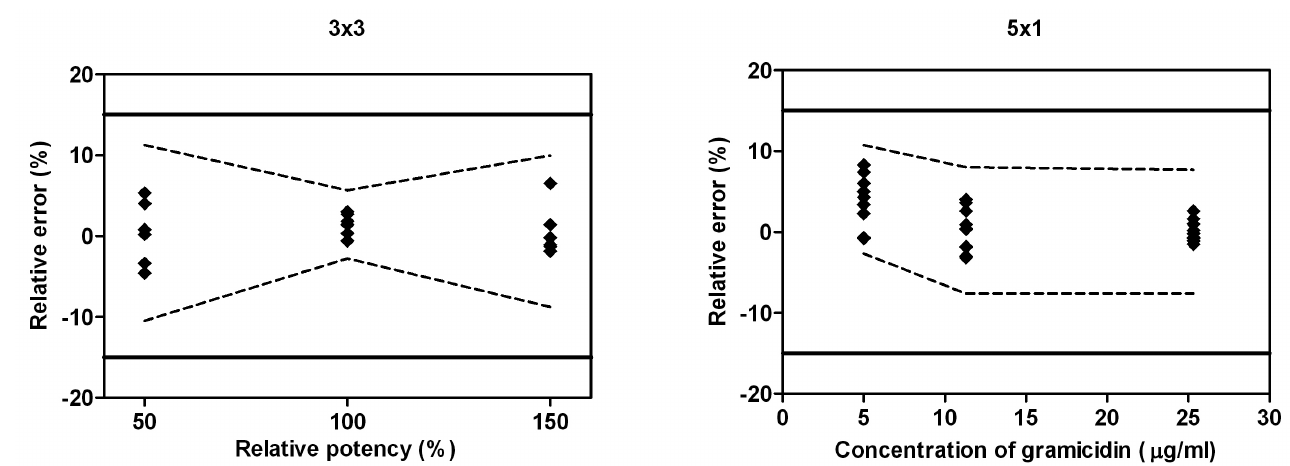
FIGURE 1 - Accuracy profile obtained for method of microbiological dosage of gramicidin using 3x3 and 5x1 designs. Dashed lines represent acceptance limits (-15%, 15%), whereas dotted lines represent 95% tolerance interval reached. When tolerance intervals are included in acceptance limits, the assay can be quantified